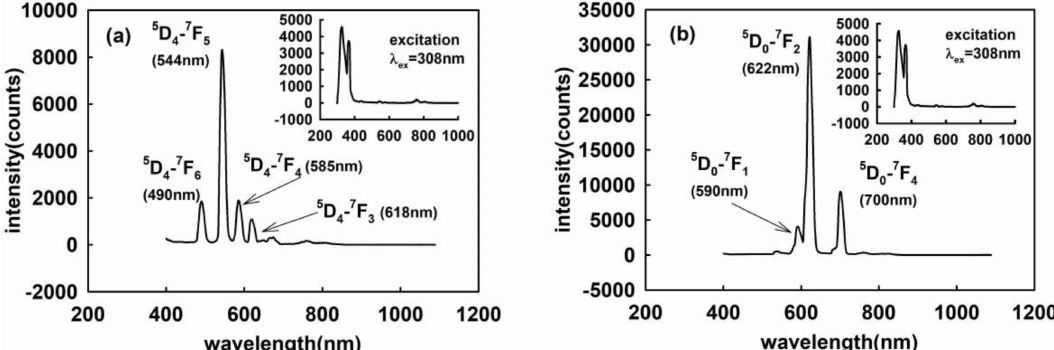
Figure 6. The emission spectra of the La 2 O 2 S ( a ) doped with Tb ( b ) doped with